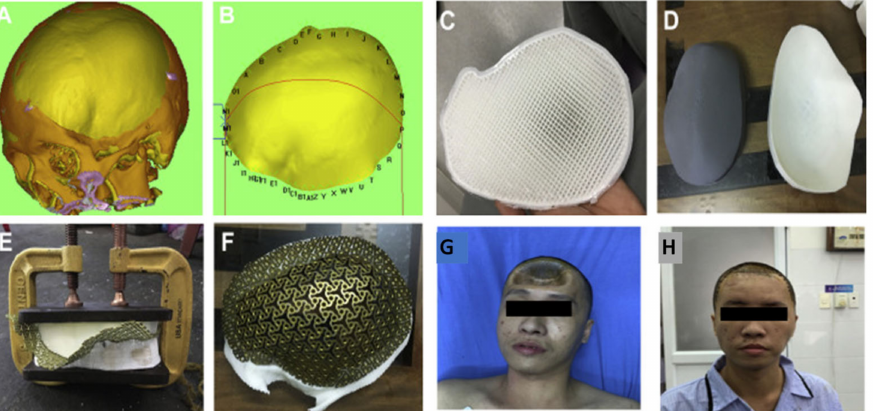
Figure 3. ( A ) ROBINS 3D image-reading software of patients’ skulls with defects. ( B ) Isolated cranial defect. ( C ) Polyurethan model used to make ( D ) cement moulds. ( E ) Moulds clamped together with titanium mesh in between. ( F ) Completed prosthetic with a specific contour for skull defect. ( G ) Patient’s head before cranioplasty indicating cranial defects in frontal regions. ( H ) Patient’s head after customized titanium implant, presenting improved aesthetic outcome due to restoration of calvarium contour